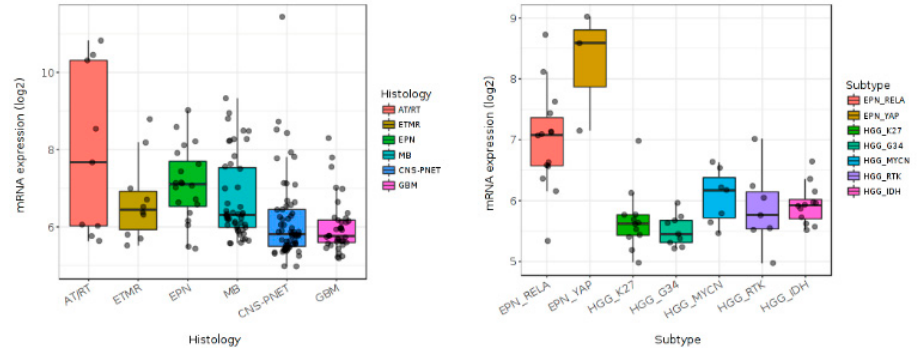
Figure 3. In silico analysis of pediatric brain tumor datasets (GEO: GSE73038) with Gliovis showing differential expression of BMP4 in pediatric central nervous system tumors ( left panel ) and pediatric high grade gliomas (right panel).